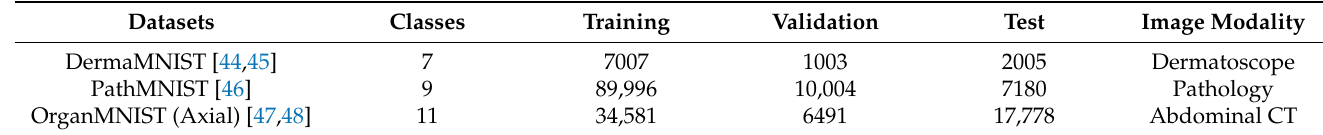
Table 1. The details of three medical image classification